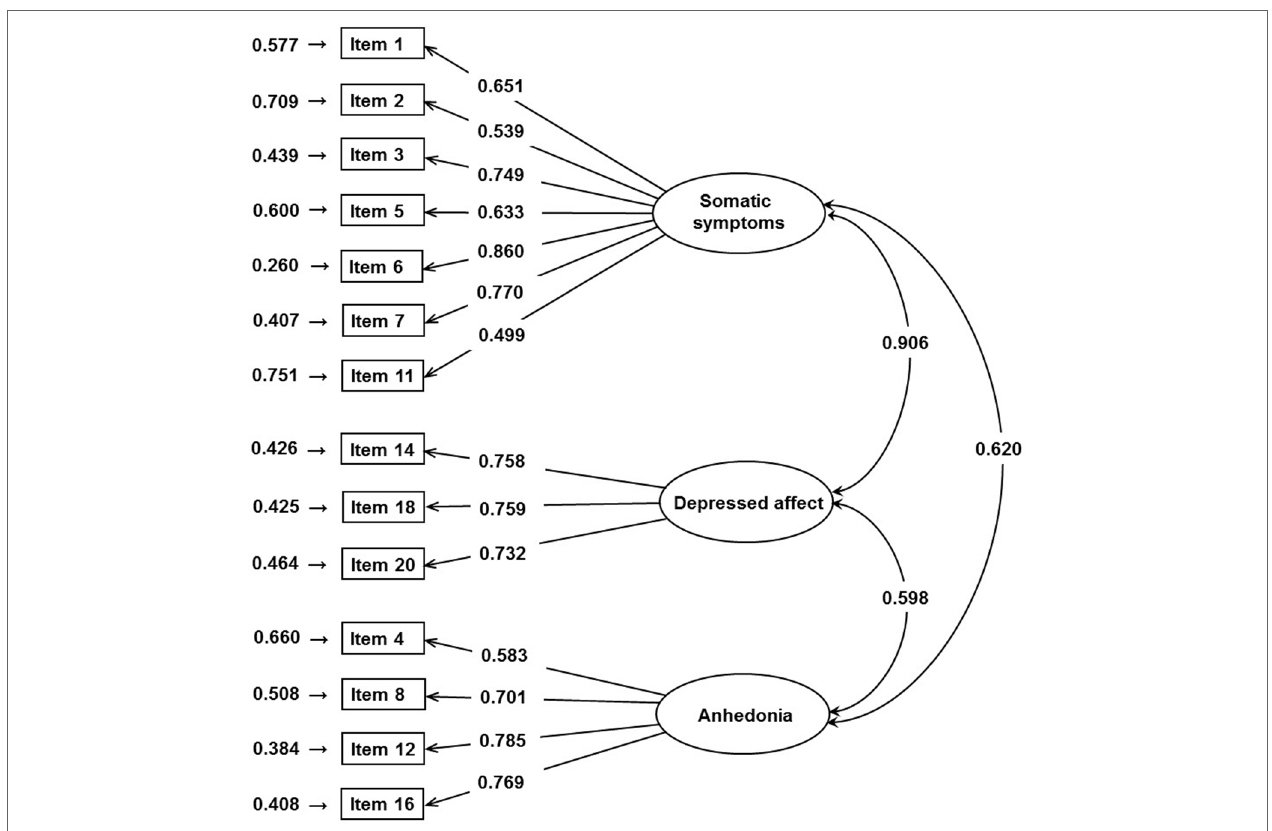
FIGURE 2 | Path diagram of the revised exploratory factor analysis (EFA) model.